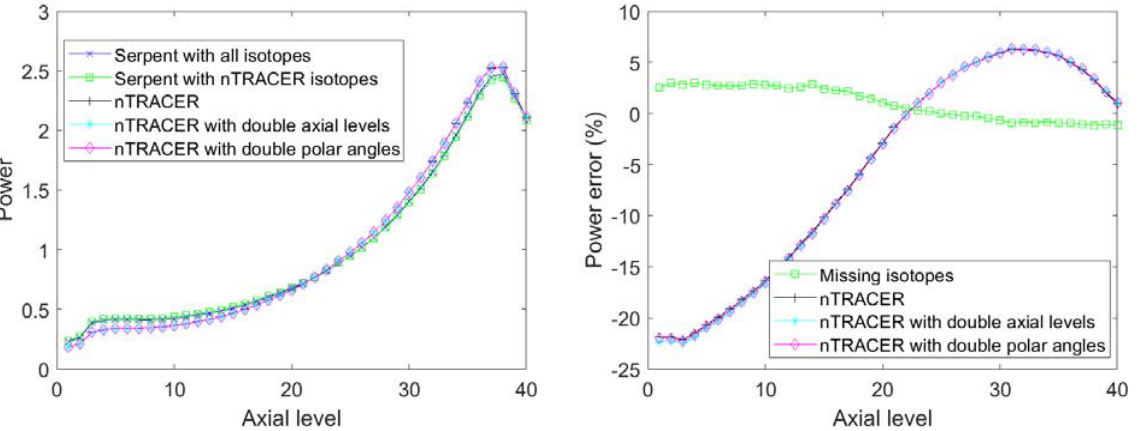
Figure 4: Axial power for 3D results. Figure 5: Power relative errors for 3D